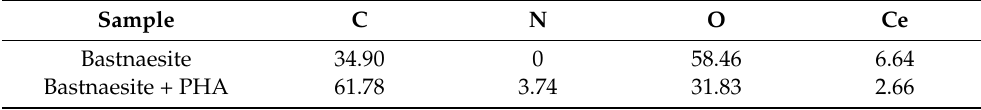
Table 3. Element concentration exist on bastnaesite